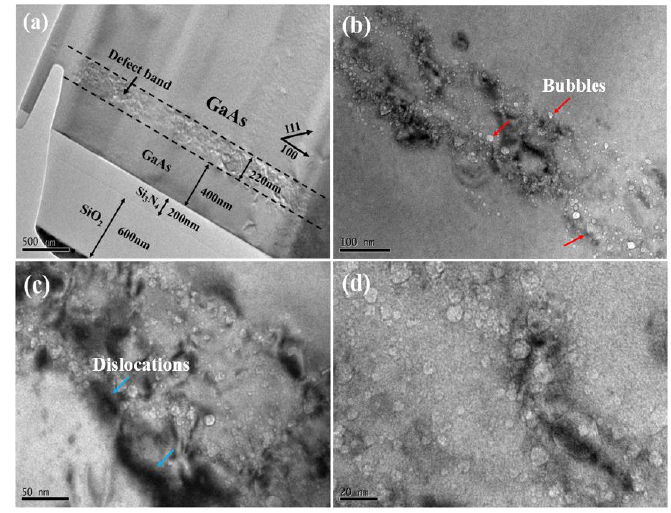
Figure 4. Cross-sectional TEM images of Sample C. ( a ) An overall cross-sectional morphology of Sample C; ( b ) Partial morphology of the damage zone; ( c ) Dislocation-like defects; ( d ) Enlarged view of dislocation-like defects and bubbles.